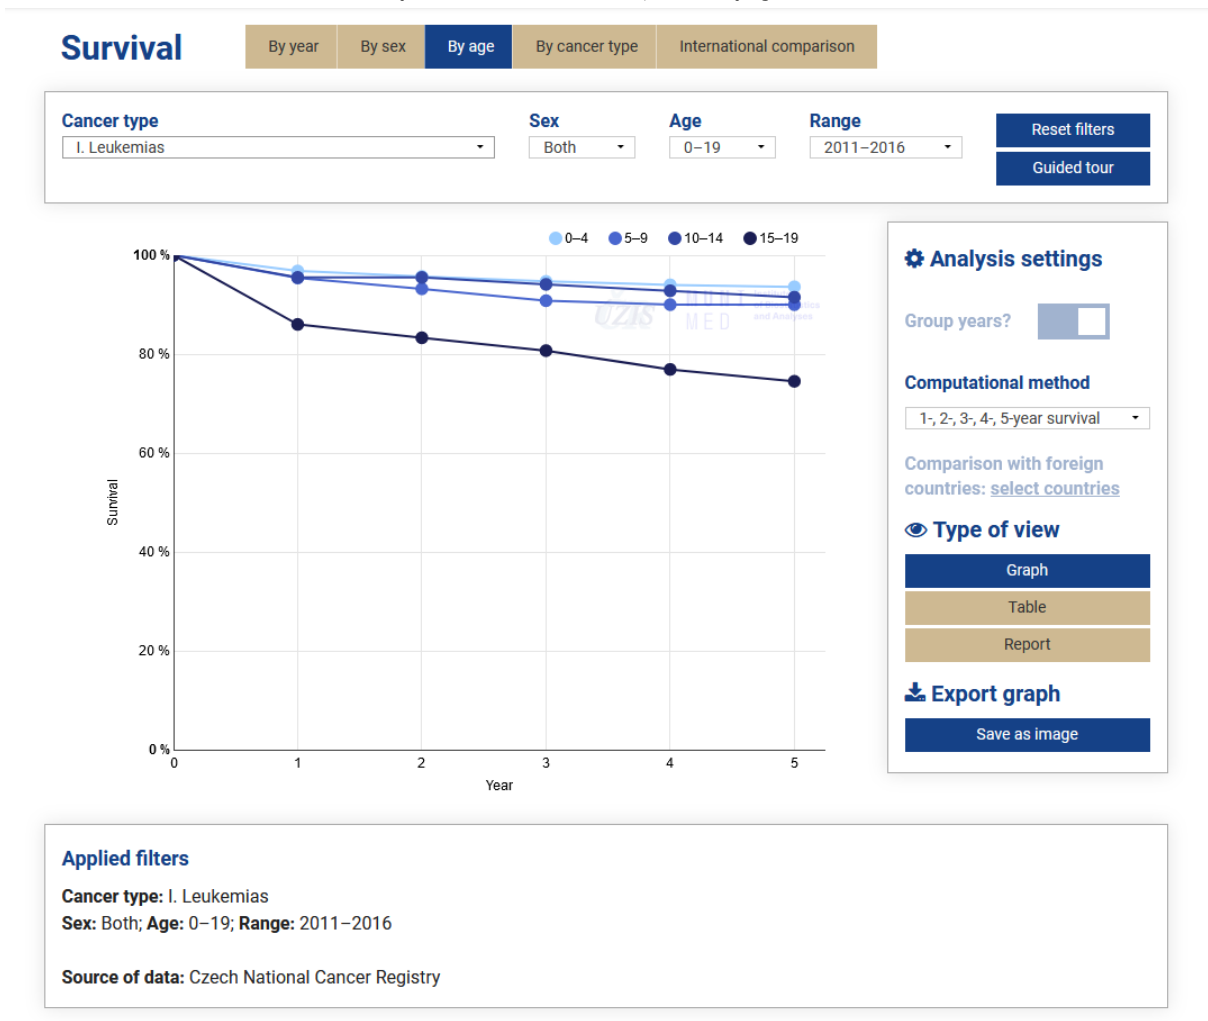
Figure 2. Czech Childhood Cancer Information System Interactive data views, survival by